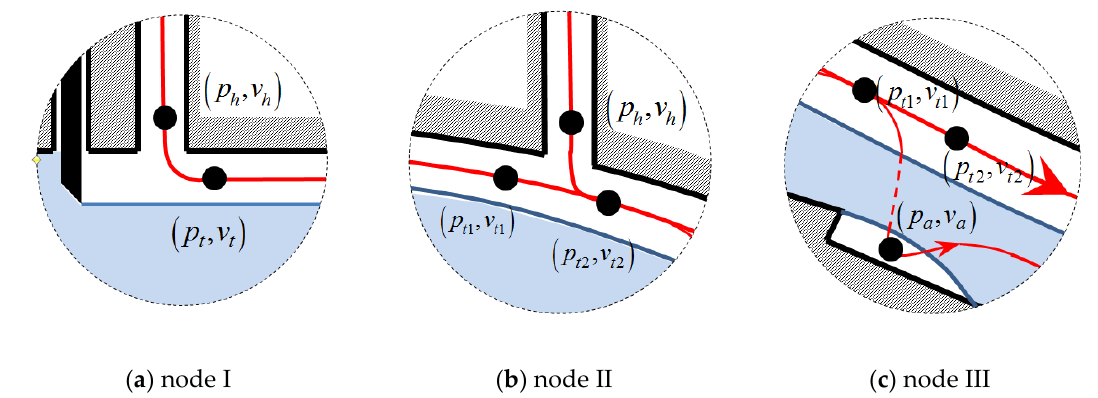
Figure 2. Airflow analysis of three specific nodes: ( a ) node I, ( b ) node II, and ( c ) node III.